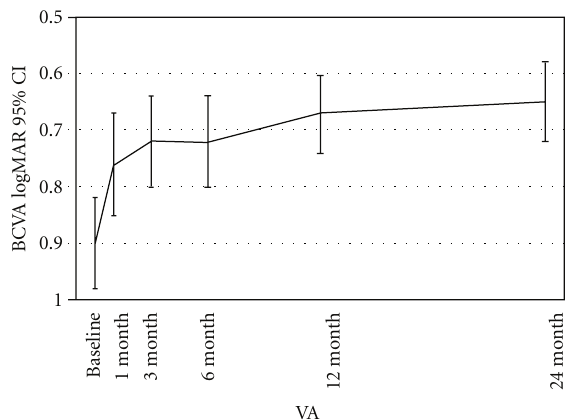
Figure 1: Changes in best-corrected visual acuity (BCVA) after intravitreal bevacizumab. BCVA improved at 1 month from 0.90 to 0.76 (logarithm of the minimum angle of resolution), a di ff erence that was statistically significant ( P < . 001), this level of BCVA was maintained throughout 3-, 6-, 12-, and 24-months. CI: confidence interval (Reprinted with permission from